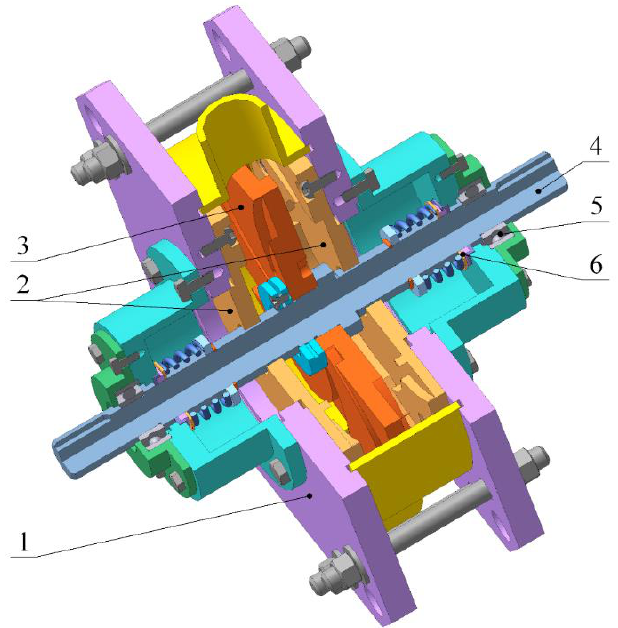
Figure 2. Structural scheme of the developed disk pulse heat generator: 1–rotor case; 2–stator disks; 3–working disk (rotor stage); 4–rotor shaft; 5–bearing; 6–sealing.